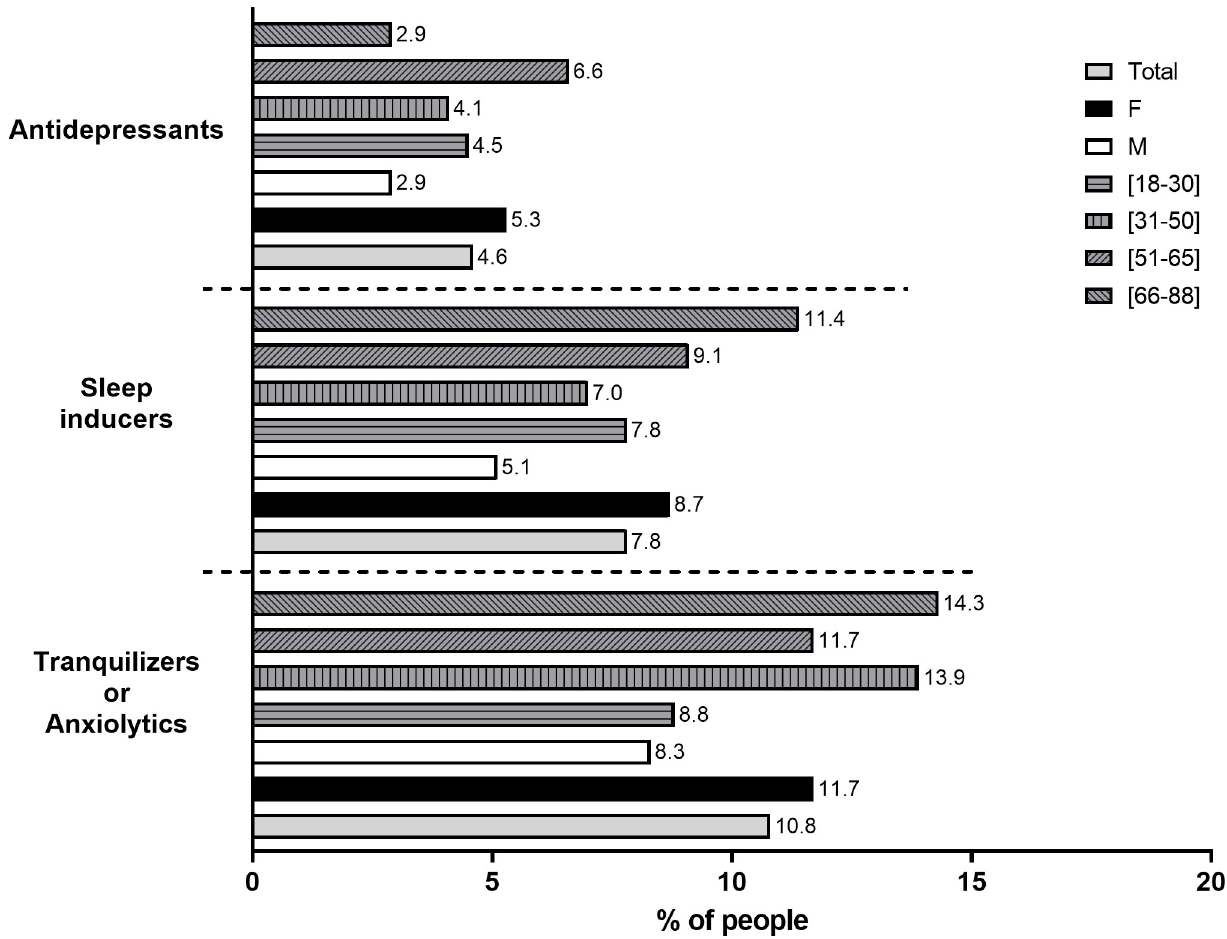
Fig 5. Consumption of pharmaceuticals, namely antidepressants or anxiolytics, sleep inducers and tranquillizers in the Portuguese population. The bars represent the percentage (%) of each analysis group; the grey bars represent a percentage of the total sample, the black bars represent the females (F), the white bars represent the males (M), the grey bars with horizontal stripes represent the individuals aged 18–30 years old, the grey bars with vertical stripes represent the people aged 31–50 years old, the grey bars with left stripes represent the individuals aged 51–65 years old and the grey bars with right stripes represent the individuals aged 66–88 years old. The Y axis represents the types of pharmaceuticals. The X axis represents the percentage (%). Individual values (in percentage) for each group are represented in front of each bar.